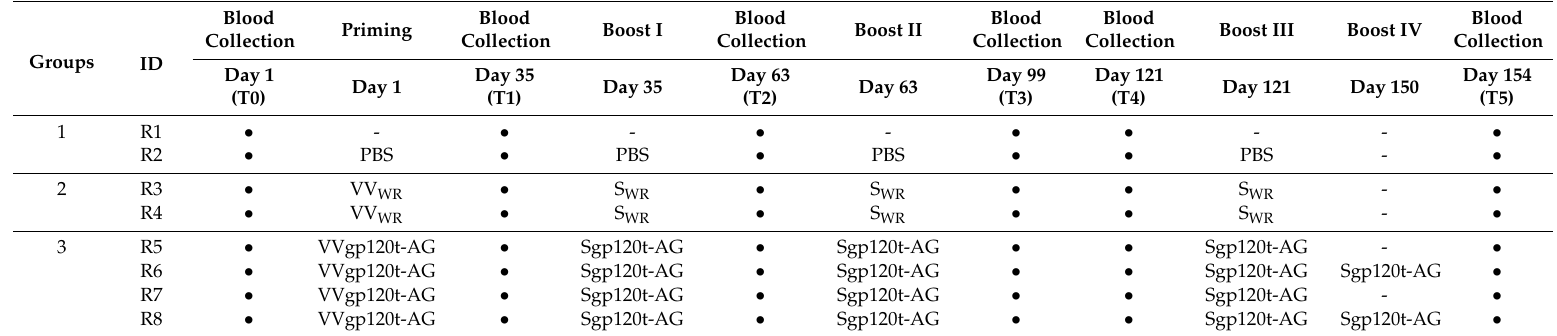
Table 3. Rabbit immunization